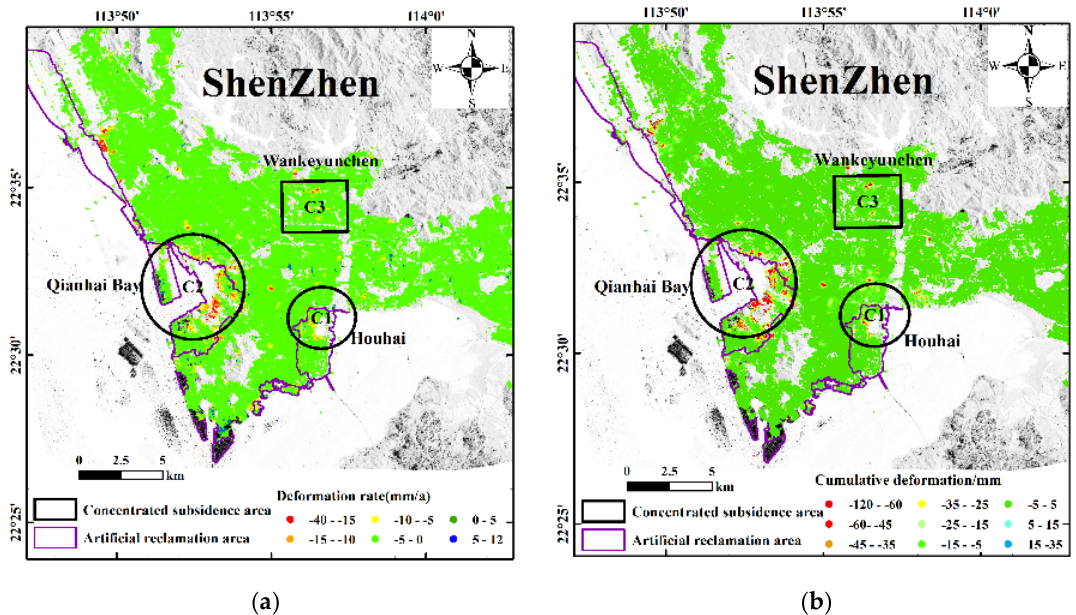
Figure 3. ( a ) Annual vertical subsidence rates based on Sentinel-1A images; ( b ) cumulative vertical subsidence rates from